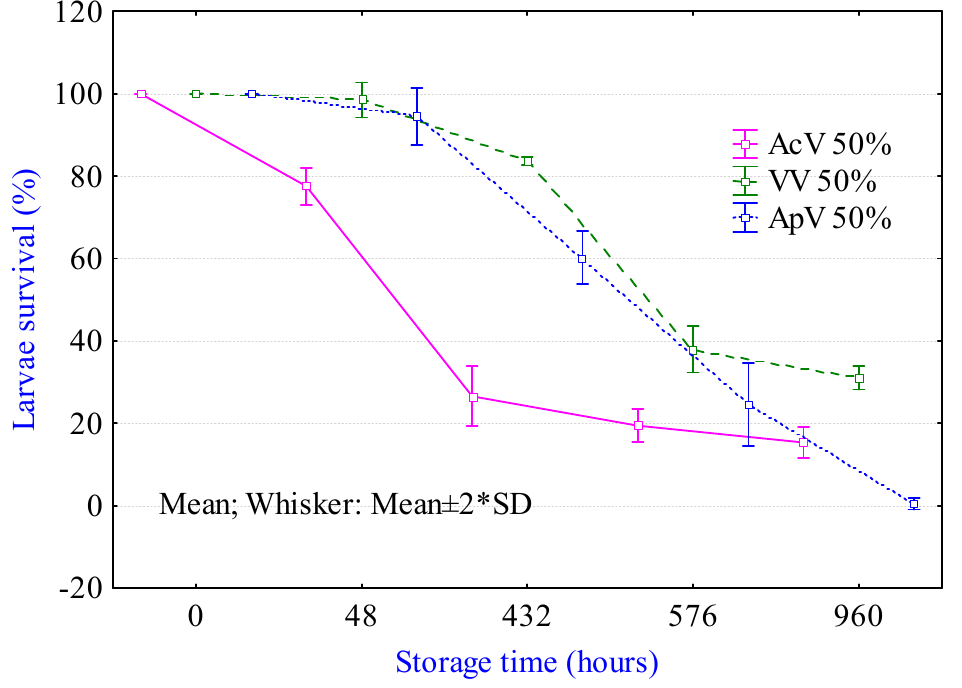
Figure 4. Survival of Anisakis spp. larvae exposed directly to water:vinegar mixtures (ratio 1:1): alcohol (AcV 50%), wine (VV 50%), and apple vinegar (ApV 50%). Survival of Anisakis spp. larvae after direct exposure to alcohol (9% acetic acid), wine (6% acetic acid), and apple vinegar (4% acetic acid), and their solutions with water are shown in Figures 3 and